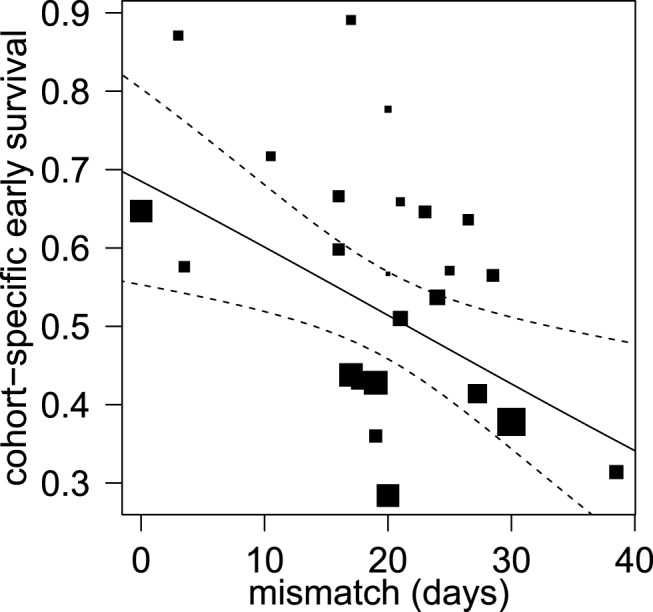
Variation in mean cohort-specific early survival in relation to the mismatch between annual median birth date and vegetation phenology in the roe deer population of Trois Fontaines, France.The predicted relationship is represented by a black line with 95% confidence intervals (dashed lines). Data used to fit the models are represented by black squares whose size is proportional to the standard error of mean cohort-specific early survival.